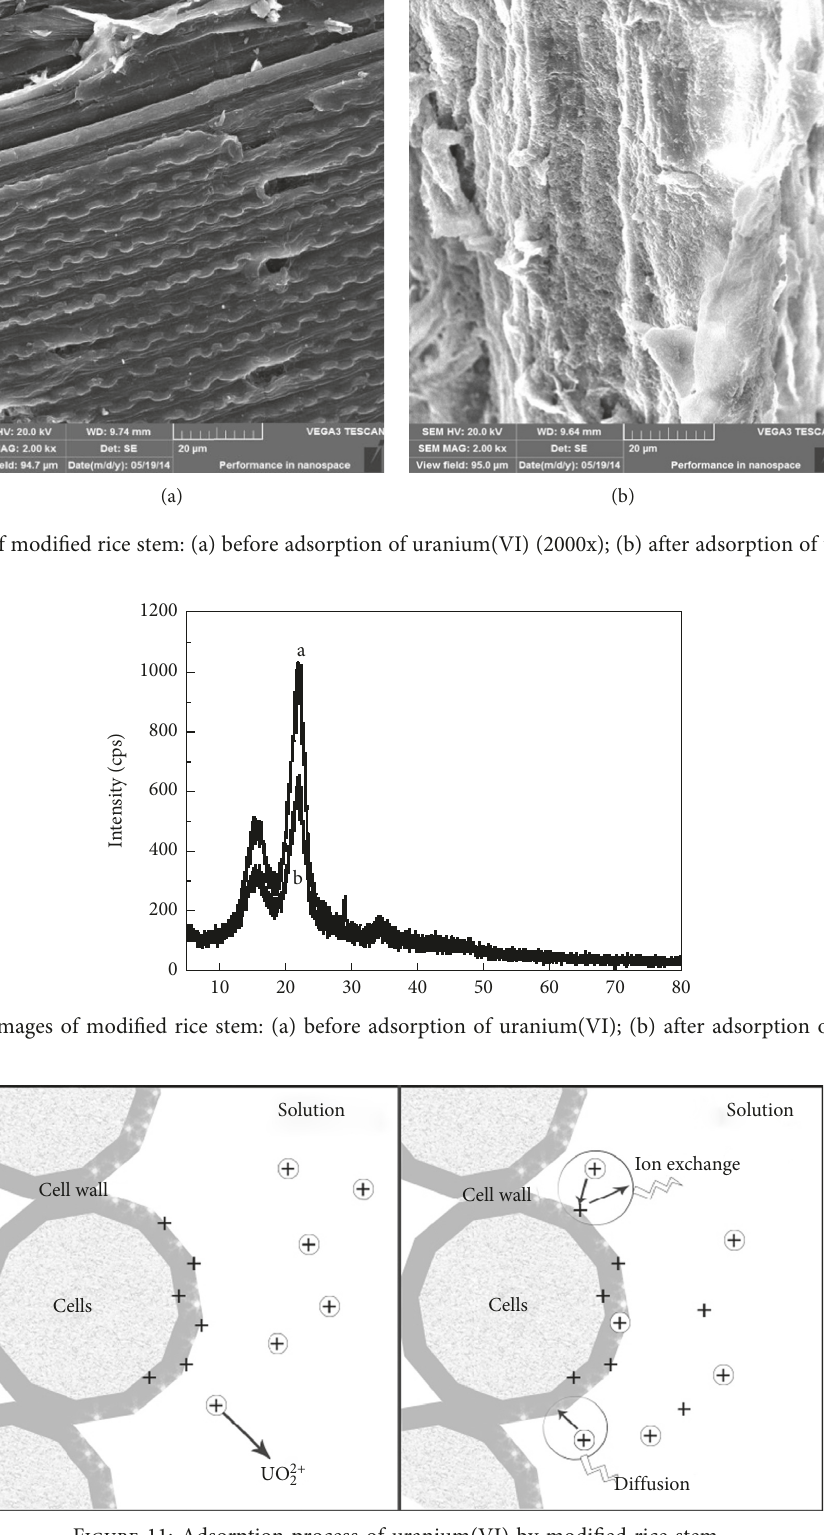
Figure 11: Adsorption process of uranium(VI) by modified rice